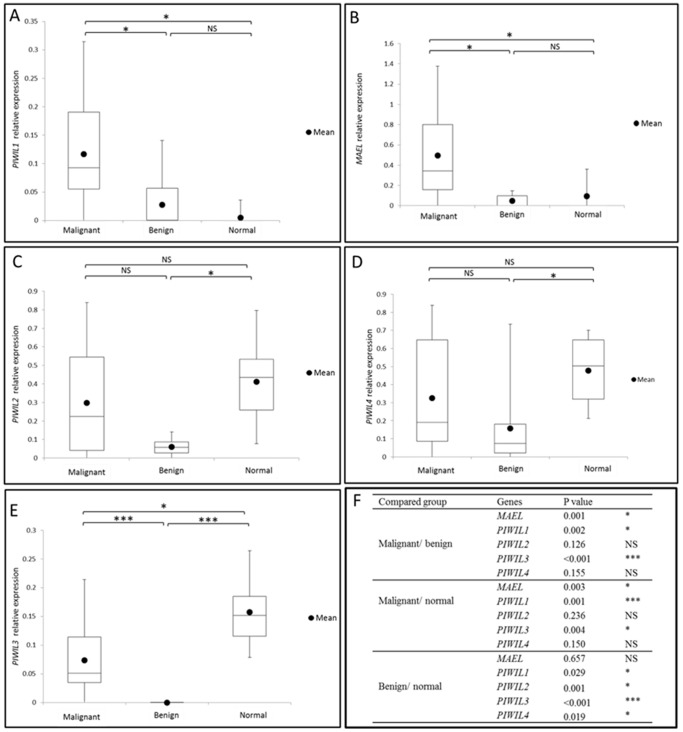
Box plot representing the expression of piRNA pathway genes in malignant EOC, benign ovarian cancer tissues and normal ovaries.Semi-quantitative RT-PCR analysis of mRNA expression (relative to ACTB) of (A) PIWIL1, (B) MAEL, (C) PIWIL2, (D) PIWIL4 and (E) PIWIL3. (F) P-value of each comparison group. Malignant EOC (n = 25), benign ovarian cancer tissues (n = 19) and normal ovaries (n = 8). Kruskal-Wallis Test was performed to compare the gene expression level between two groups. Filled dot indicates mean of each group. * indicates 0.001<P<0.05; *** indicates P<0.001; NS, not significant.